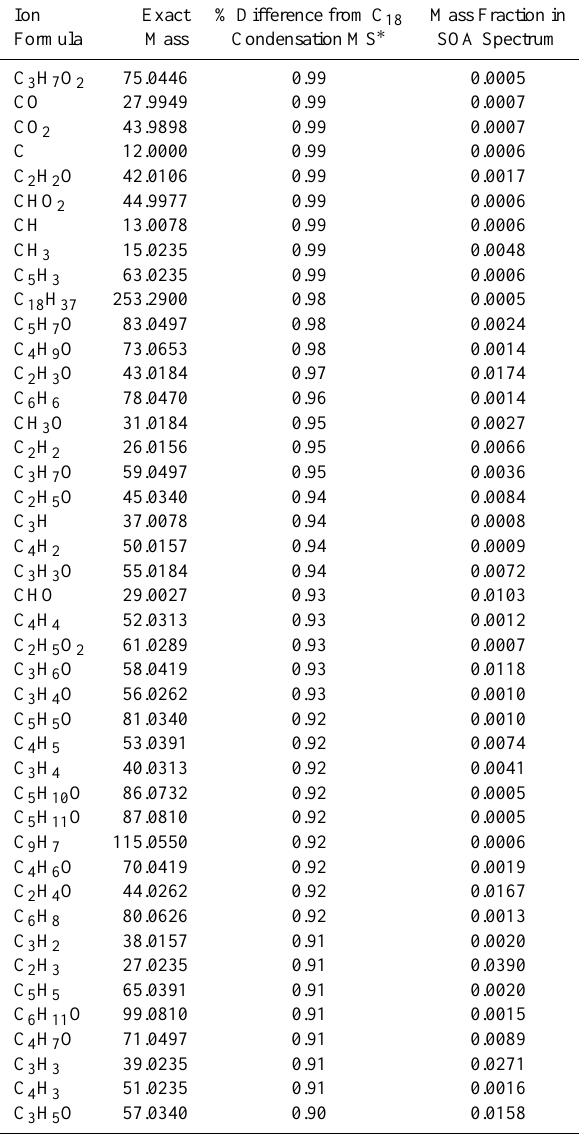
Table 4. Distinct ions present in early C 18 SOA formation. Ion Exact % Difference from C 18 Mass Fraction in Formula Mass Condensation MS ∗ SOA